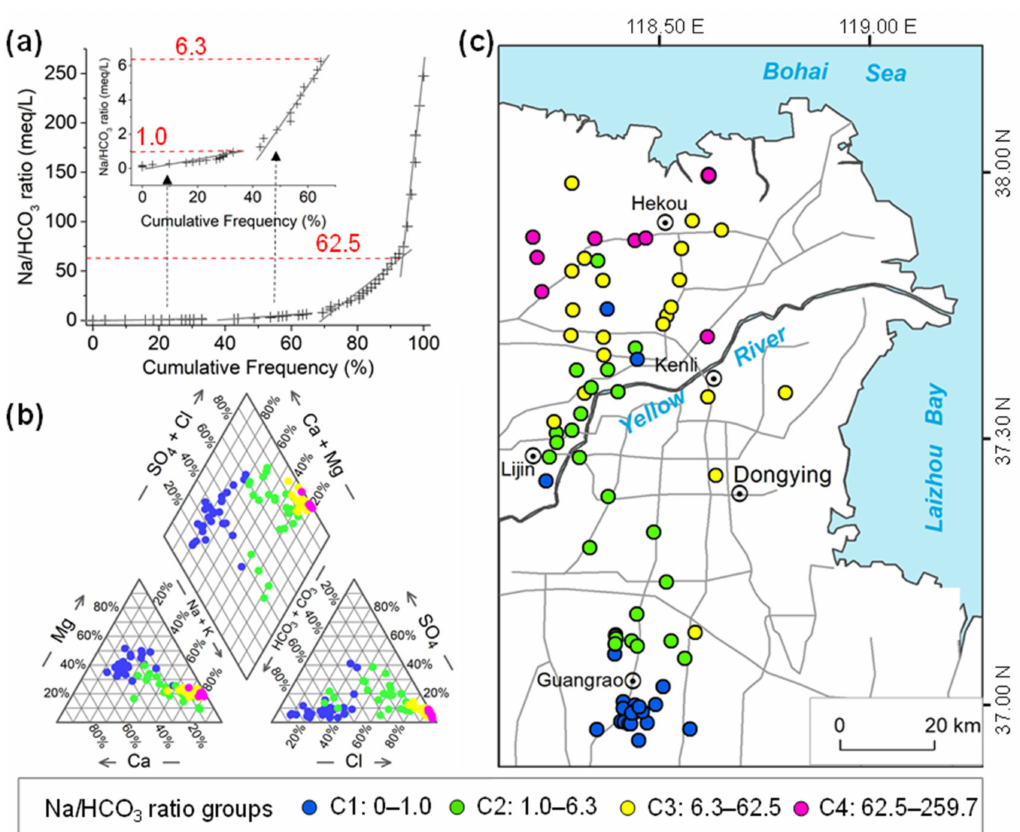
Figure 7. Cumulative frequency distribution curve for Na/HCO 3 ratios ( a ); representation of groupings in the Piper diagram ( b ); and distribution of Na/HCO 3 groups in the study area ( c